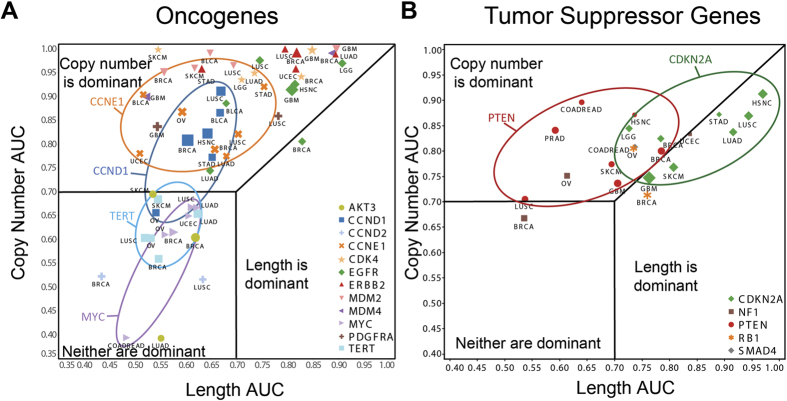
The ability of length and amplitude to independently predict high-magnitude oncogenic driver expression changes are a property of the gene locus regardless of cancer type.ROC-AUC values for 17 (a) oncogenes and (b) tumor suppressor genes measuring the ability of either SCNA copy number (y-axis) or SCNA length (x-axis) to independently predict samples with high expression changes. Selected oncogenes and tumor suppressors are circled to highlight the gene locus-centric clustering (blue: CCND1, orange: CCNE1, purple: MYC, cyan: TERT, red: PTEN, green: CDKN2A). Only cancers are shown in which at least 15 focal SCNAs (<10 Mb) were identified for a given gene. The size of each marker correlates with the number of focal SCNAs.